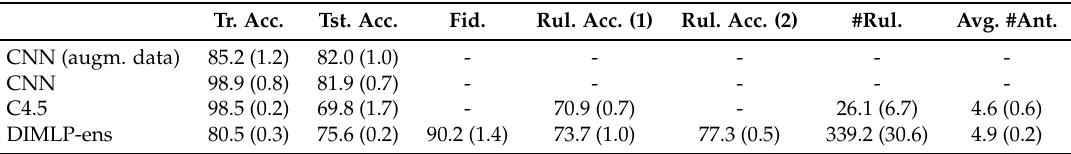
Table 5. Results obtained by CNNs, decision trees and ensembles of DIMLPs on the skin-cancer dataset with 28 × 28 images. The first row is related to the results with data augmentation during training. Tr. Acc. Tst. Acc. Fid. Rul. Acc. (1) Rul. Acc. (2) #Rul. Avg. #Ant. CNN (augm. data) 85.2 (1.2) 82.0 (1.0) - -